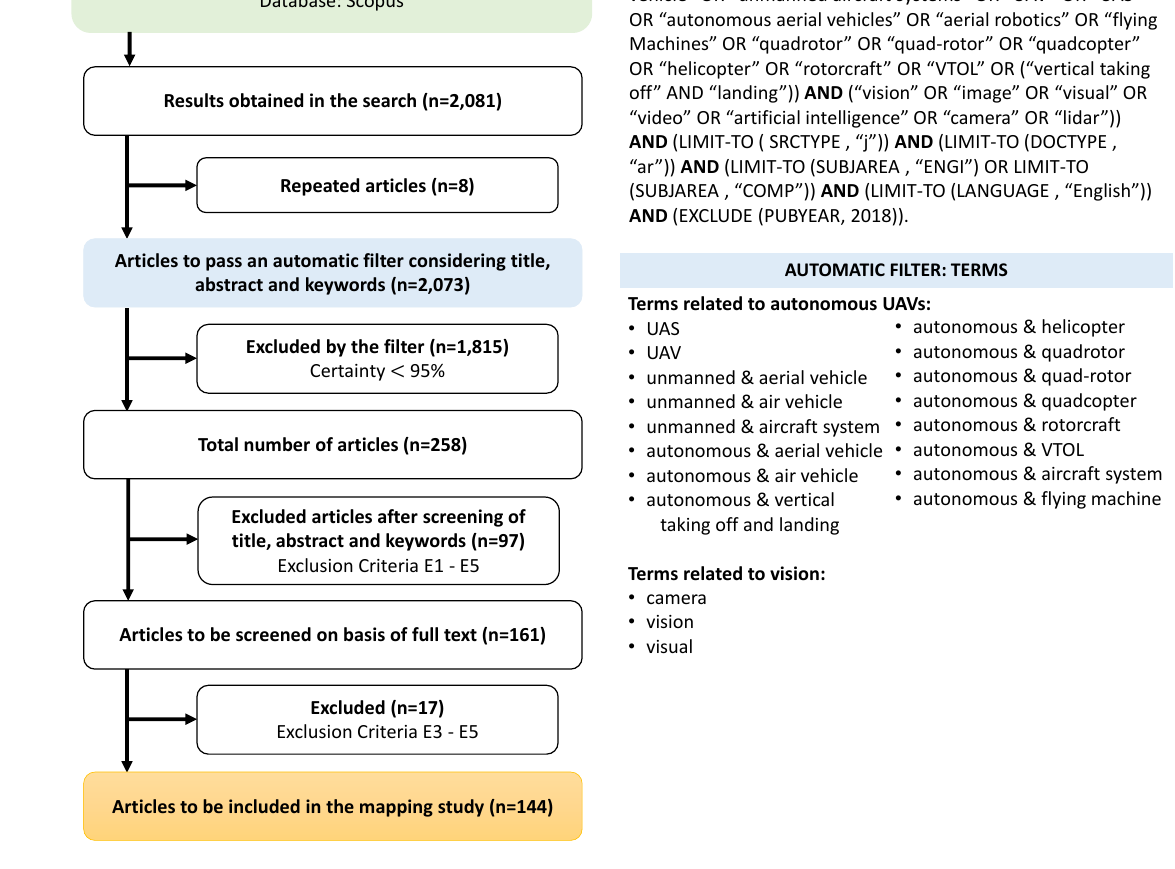
Figure 2. Systematic search consort